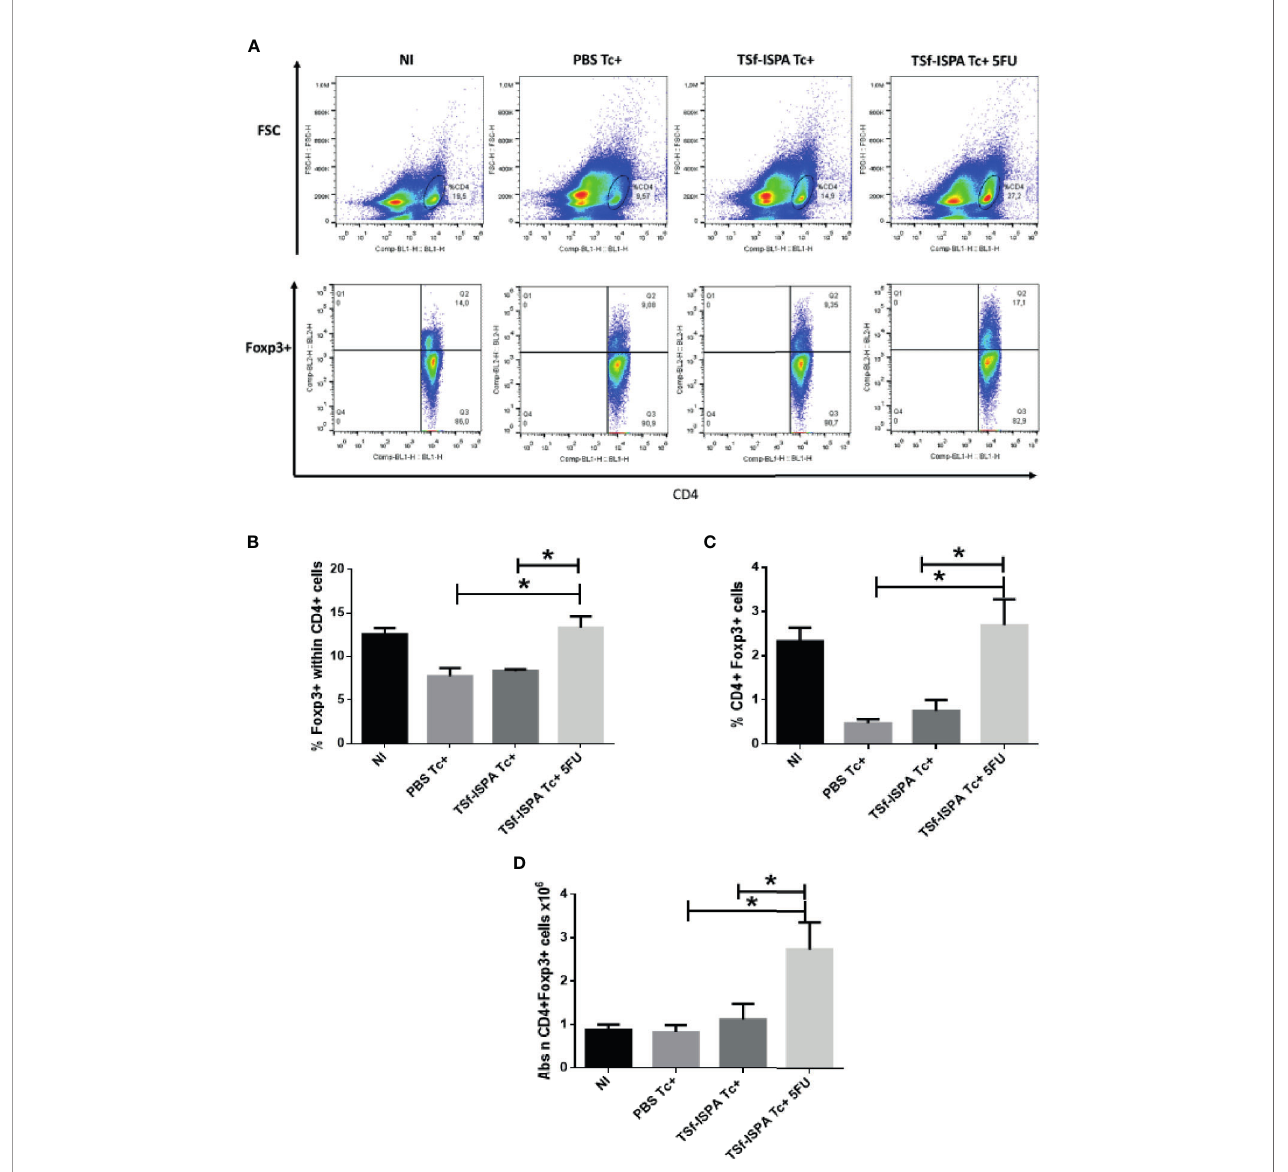
FIGURE 4 | MDSC depletion increases Tregs. Mice immunized with TSf-ISPA or PBS were treated or not with 5FU and challenged with 900 trypomastigotes of the Tulahuen strain. At 21 day p.i., mice were sacri fi ced to analyze the expression of Foxp3 and CD4 by FACS in control non-infected (NI), PBS-inoculated and infected mice (PBS Tc+), TSf-ISPA immunized and infected mice (TSf-ISPA Tc+) and TSf-ISPA immunized, infected and 5FU treated mice (TSf-ISPA Tc+ 5FU). (A) Representative dot plots of the expression of CD4 vs forward scatter and CD4 vs Foxp3 expression in the indicated region of experimental groups under study: (B) Percentage of Foxp3+ expression in CD4+ cells. (C) Percentage of CD4+ Foxp3+ cells, (D) Absolute number of CD4+ Foxp3+ cells x10 6 . Data are expressed as means + standard deviations. The results are representative of three independent experiments (n = 3-5 mice per group, according to the survival of the experiment). *p < 0,05 between indicated groups of